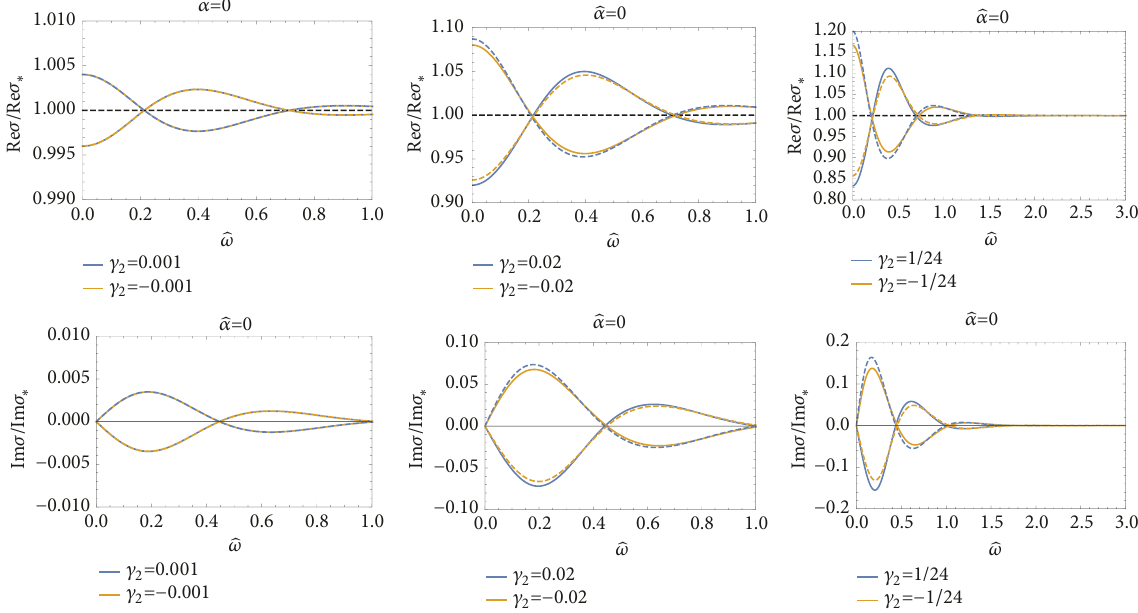
Figure 19: The real part (the plot above) and the imaginary part (the plot below) of the optical conductivity as the function of ̂𝜔 for ̂𝛼 = 0 and various values of 𝛾 2 . The solid curves are the conductivity 𝜎 of the original EM theory (4) and the dashed curves display the conductivity 𝜎 ∗ of the EM dual theory